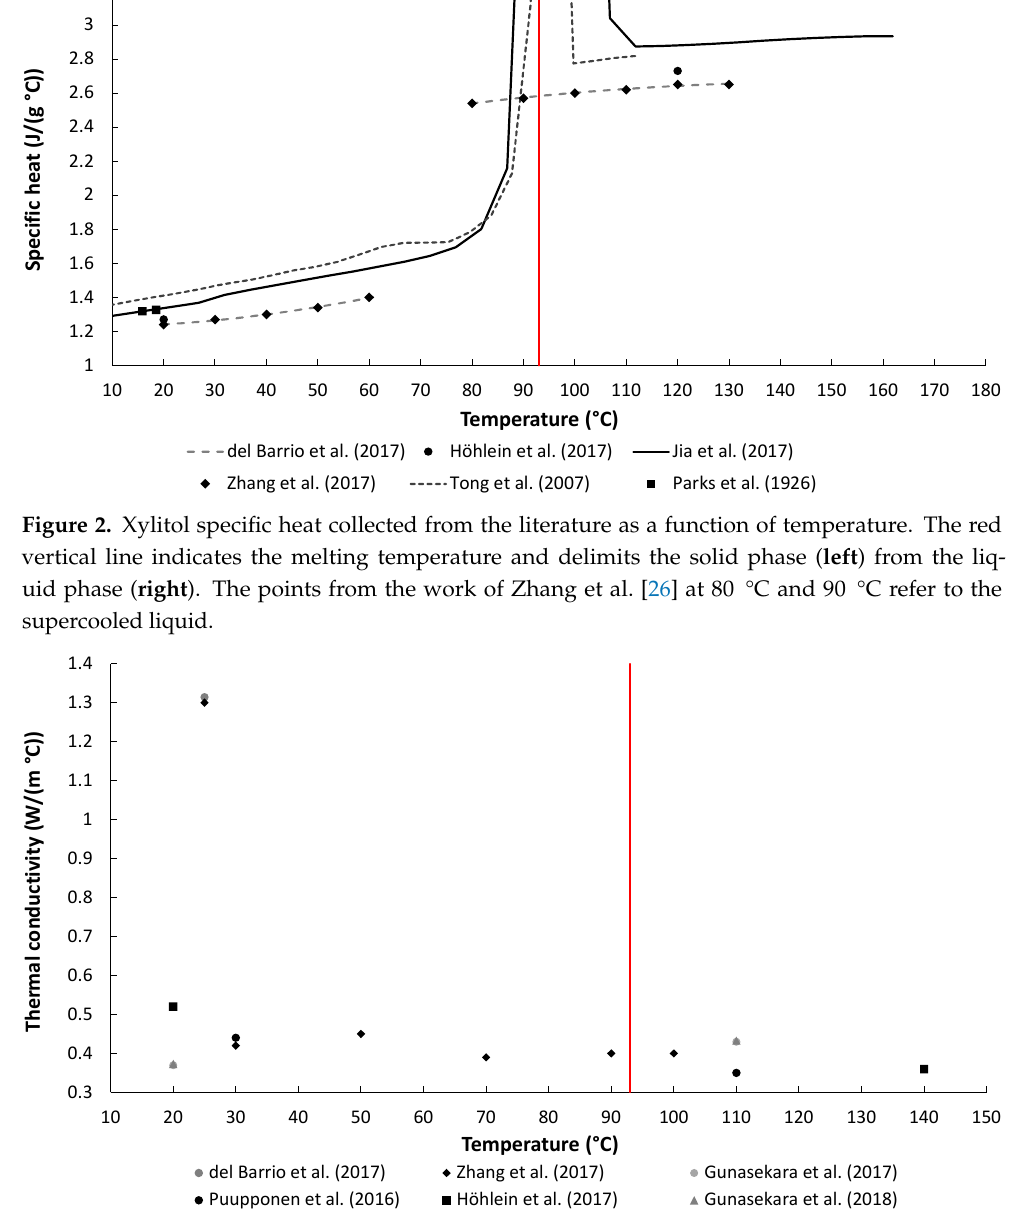
Figure 3. Xylitol thermal conductivity collected from literature as a function of temperature. The red vertical line indicates the melting temperature and delimits the solid phase ( left ) from the liquid phase ( right ). The points from the work of Zhang et al. [26] in the temperature range 30–90 °C refer to the supercooled